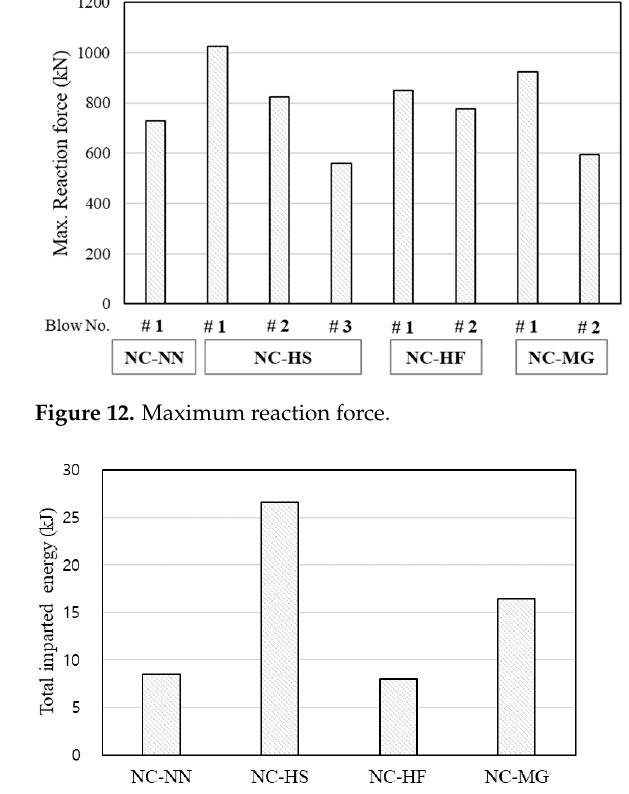
Figure 13. Total imparted energy until failure.